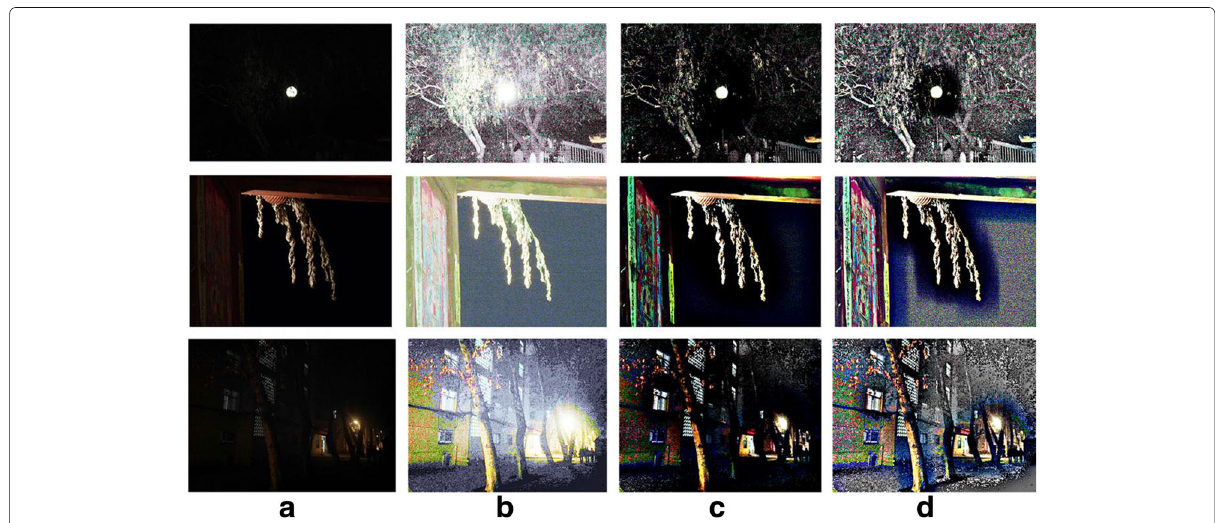
Fig. 2 Nighttime image enhancement results with different methods. a Input image. b Enhanced image with histogram equalization [8]. c Enhanced image with single-scale retinex (SSR) [11]. d Enhanced image with multi-scale retinex (MSR)